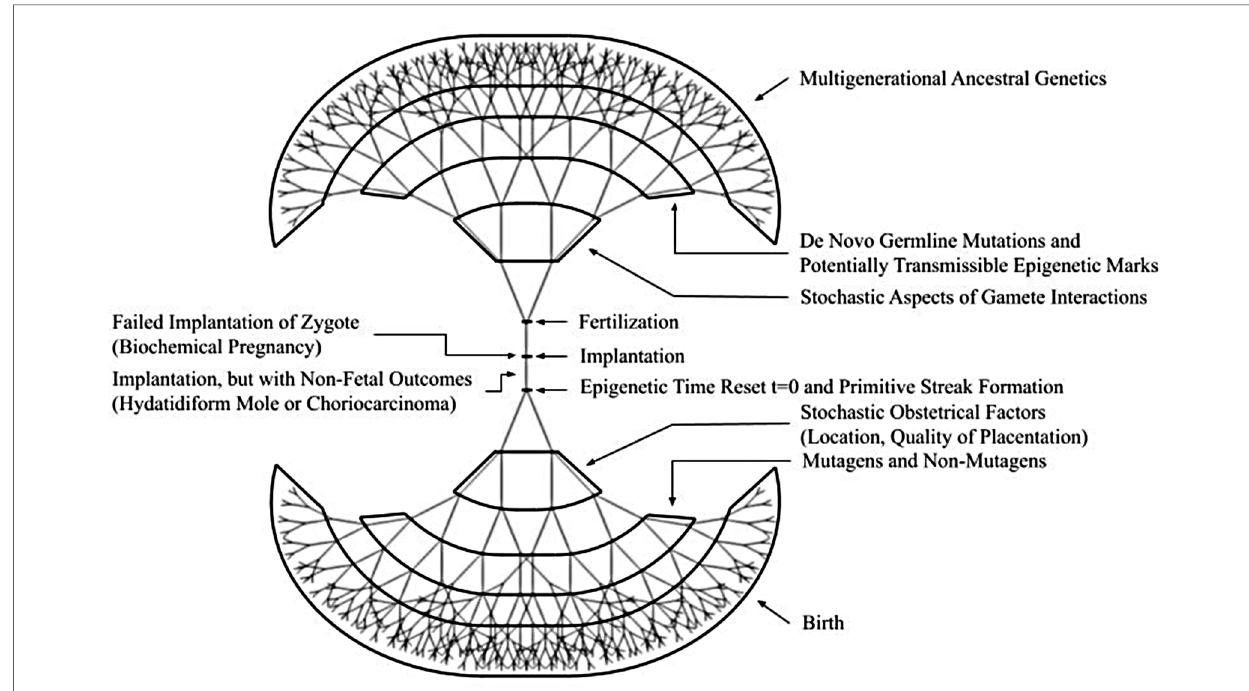
FIGURE 1 Framework for sources of diversity for developmental individualization of potential and future humans. Both pre-fertilization (the upright tree) and post- fertilization (the shared trunk and inverted tree) elements illustrate the complexity* of endogenous and exogenous events and processes by which attributes of personhood are incrementally acquired. The fractal-like elements are intended to be evocative in that future non-deterministic mathematical modeling could be undertaken. *The items in the fi gure are representative, not